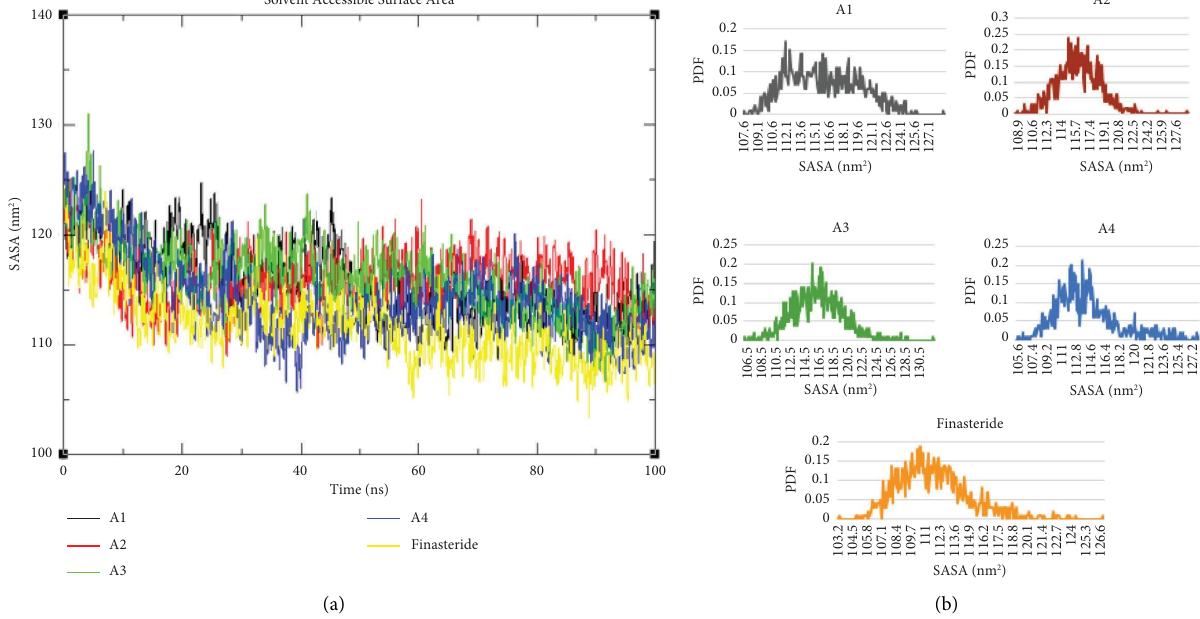
Figure 8: Te SASA analysis of 100ns molecular dynamics simulations of the hit complexes and fnasteride: (a) SASA plot for the four selected complexes; (b) PDF of SASA for the selected lead